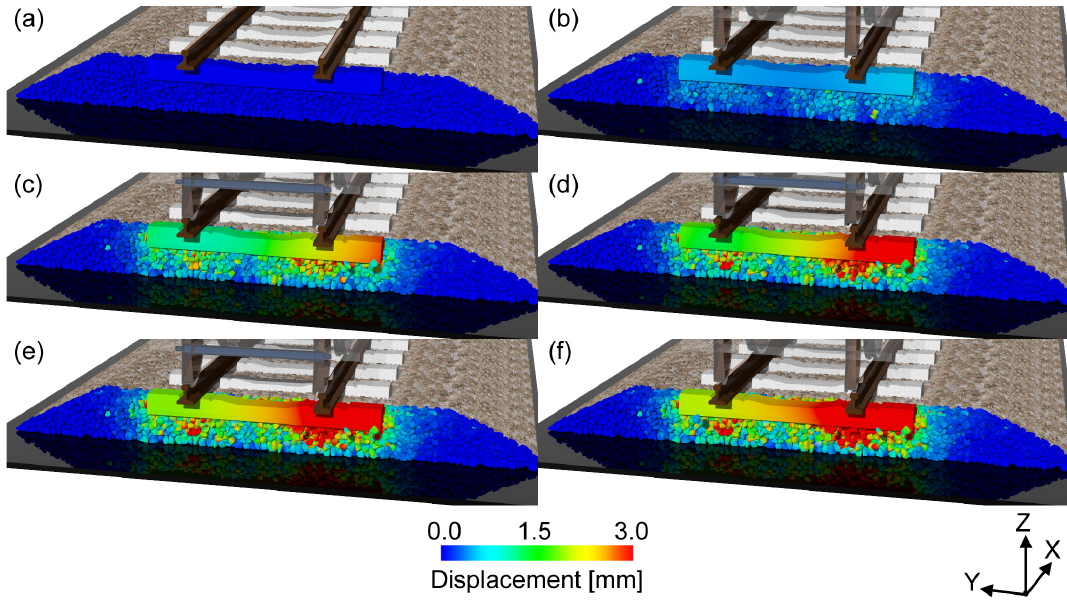
Figure 7. Snapshots of displacement of the ballast particle and sleeper at each traveling time tof the train: ( a ) t = 0.0 s, ( b ) t = 0.11 s, ( c ) t = 0.73 s, ( d ) t = 1.35 s, ( e ) t = 1.98 s and ( f ) t = 2.61 s. The displacement is shown with a magnification of 20 × . A video sequence of this simulation can be found as the Supplementary Material in Video